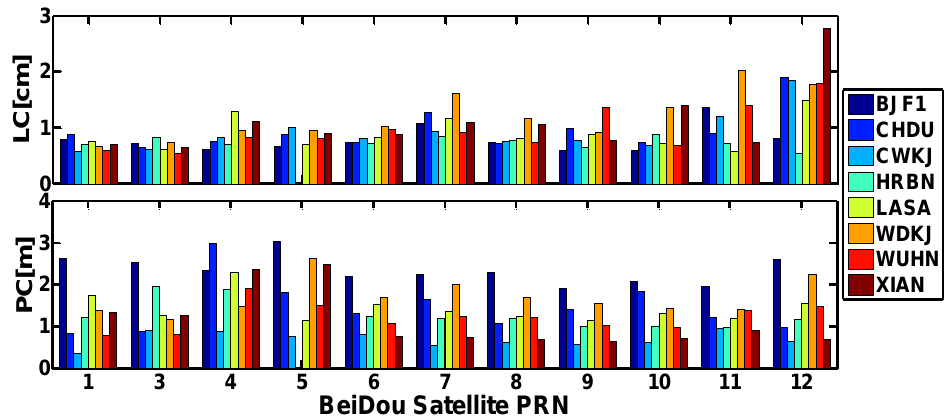
Figure 12. RMS values of undifferenced LC and PC residuals for the BeiDou satellites of all individual